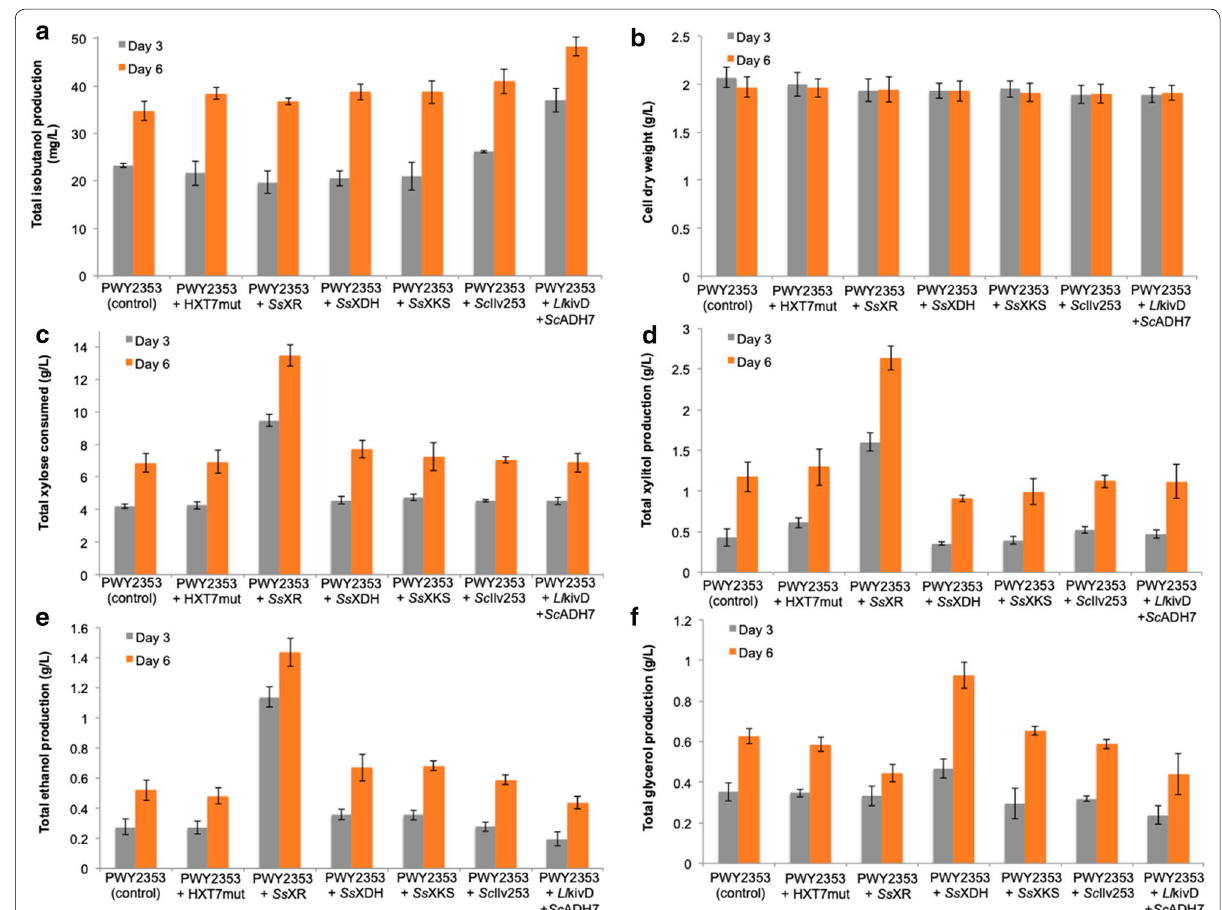
Fig. 5 Characterization of engineered strains with low-copy plasmid-based overexpression of individual pathway genes. Total isobutanol production ( a ), cell dry weight ( b ), xylose consumption ( c ), xylitol production ( d ), ethanol production ( e ), and glycerol production ( f ). Individual gene construct was placed in the pRSII416 plasmid and transform into PWY2353. All strains were cultured in selective medium containing 2% xylose as the sole carbon source. Values are the mean of three biological replicates